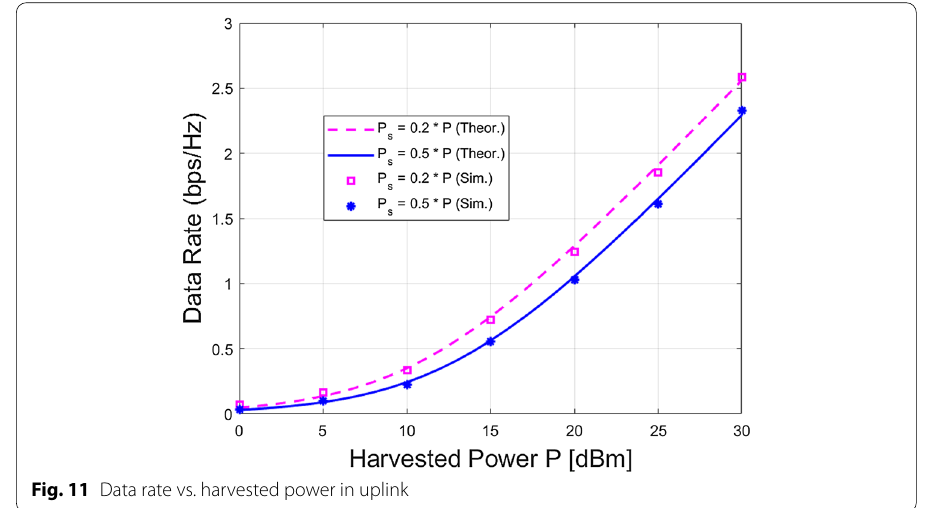
Fig. 11 Data rate vs. harvested power in uplink